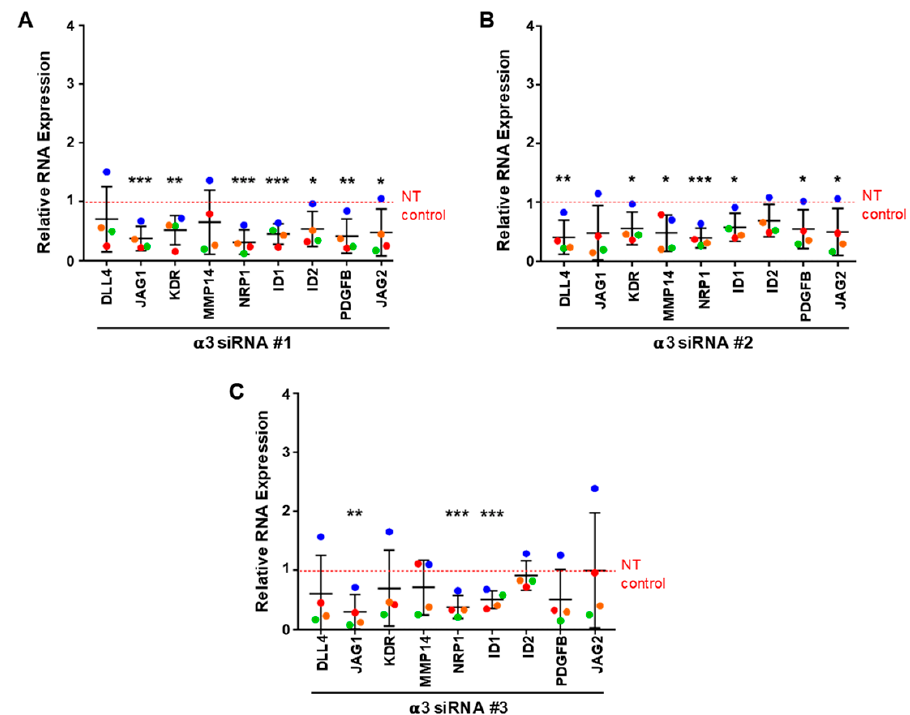
Figure 8. Regulation of angiogenesis-associated genes by integrin α 3 β 1. Changes in RNA expression in 5-day bead-sprout assays of α 3-depleted endothelial cells and control were measured by qPCR. The efficiency of α 3 depletion using 3 siRNA targeting sequences previously shown in Figure 7.